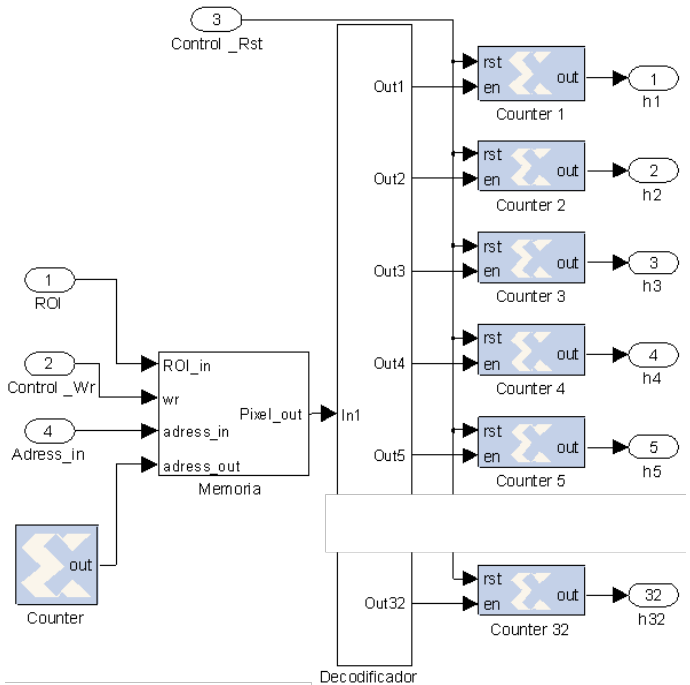
Figure 6. Histogram computation